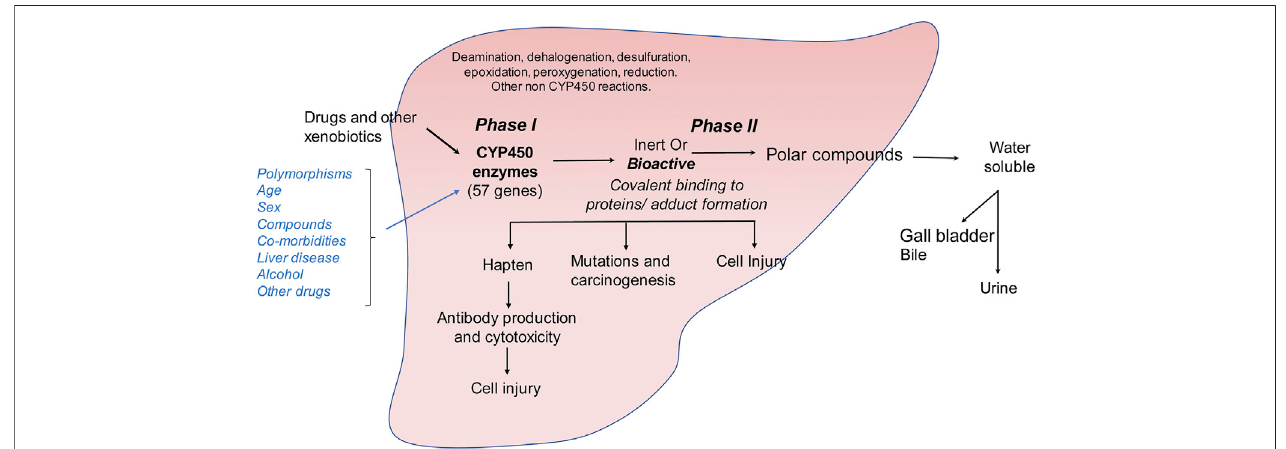
FIGURE3| Metabolismofdrugsandotherxenobioticsintheliver.Drugandxenobioticmetabolismoccursintwophases:( i )phaseIiscatalyzedbythecytochrome P450 family of monooxygenases which metabolize ingested small molecules to form inert or bioactive metabolic intermediates. ( ii ) These intermediates are further catalyzed in phase II reactions to form soluble polar compounds that can be further excreted through urine or bile. Accumulation of bioactive drug or xenobiotic intermediates can lead to the formation of protein or nucleic acid adducts causing autoimmune reaction, carcinogenesis or direct cellular injury.